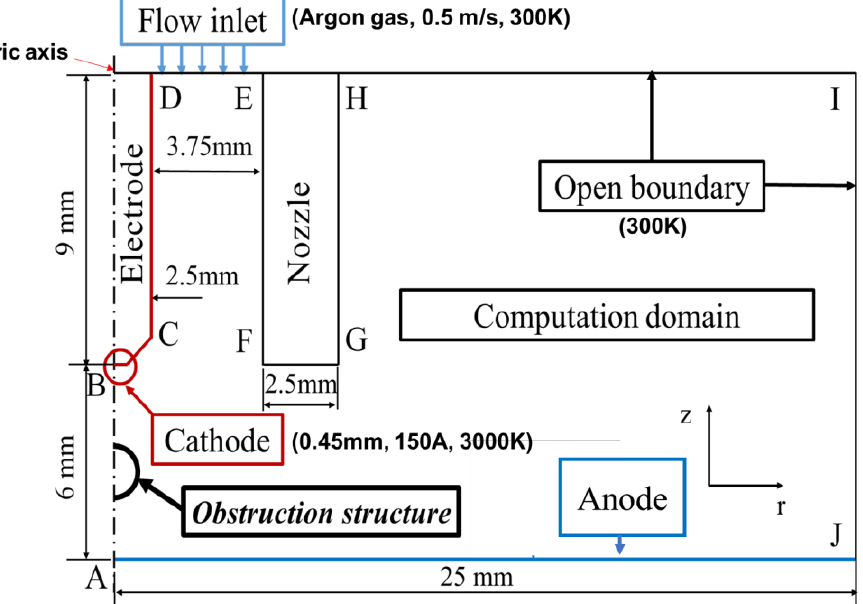
Figure 1. Computational domain for arc plasma simulation with rod cathode and flat anode.